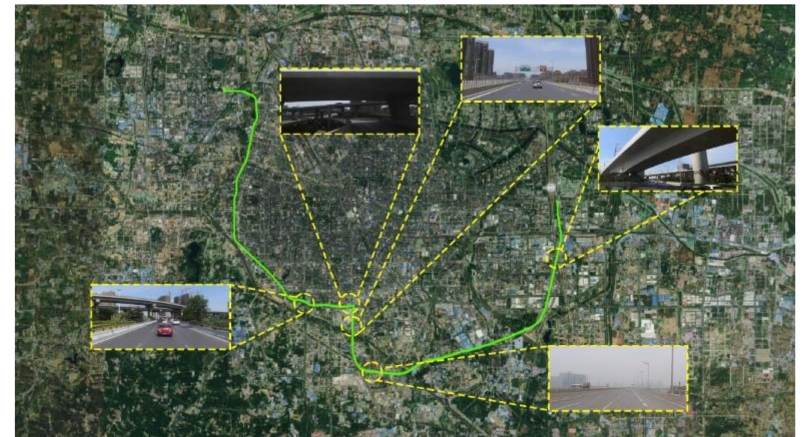
Figure 3. The trajectory of experiment B.